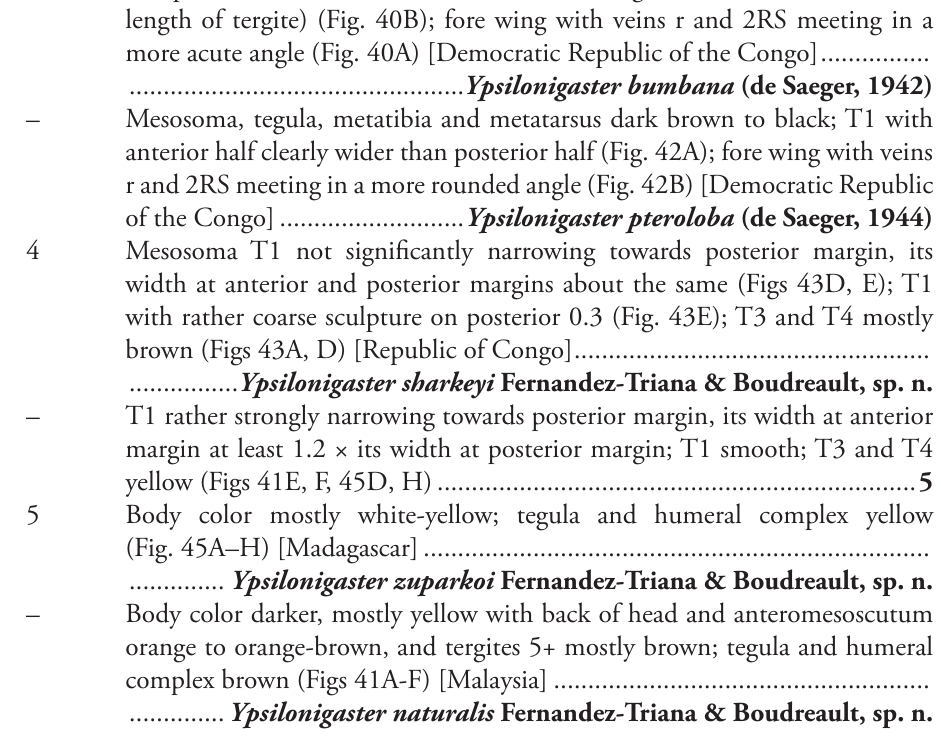
Mesosoma, tegula, metatibia and metatarsus red-yellow; T1 with anterior and posterior halves of similar width (with a slight constriction around half length of tergite) (Fig. 40B); fore wing with veins r and 2RS meeting in a more acute angle (Fig. 40A) [Democratic Republic of the Congo] ................ ................................................. Ypsilonigaster bumbana (de Saeger, 1942) – Mesosoma, tegula, metatibia and metatarsus dark brown to black; T1 with anterior half clearly wider than posterior half (Fig. 42A); fore wing with veins r and 2RS meeting in a more rounded angle (Fig. 42B) [Democratic Republic of the Congo] ........................... Ypsilonigaster pteroloba (de Saeger, 1944) 4 T1 not significantly narrowing towards posterior margin, its width at anterior and posterior margins about the same (Figs 43D, E); T1 with rather coarse sculpture on posterior 0.3 (Fig. 43E); T3 and T4 mostly brown (Figs 43A, D) [Republic of Congo] .................................................... ................ Ypsilonigaster sharkeyi Fernandez-Triana & Boudreault, sp. n. – T1 rather strongly narrowing towards posterior margin, its width at anterior margin at least 1.2 × its width at posterior margin; T1 smooth; T3 and T4 yellow (Figs 41E, F, 45D, H) ...................................................................... 5 5 Body color mostly white-yellow; tegula and humeral complex yellow (Fig. 45A–H) [Madagascar] .......................................................................... .............. Ypsilonigaster zuparkoi Fernandez-Triana & Boudreault, sp. n. – Body color darker, mostly yellow with back of head and anteromesoscutum orange to orange-brown, and tergites 5+ mostly brown; tegula and humeral complex brown (Figs 41A-F) [Malaysia] ....................................................... .............. Ypsilonigaster naturalis Fernandez-Triana & Boudreault, sp. n.